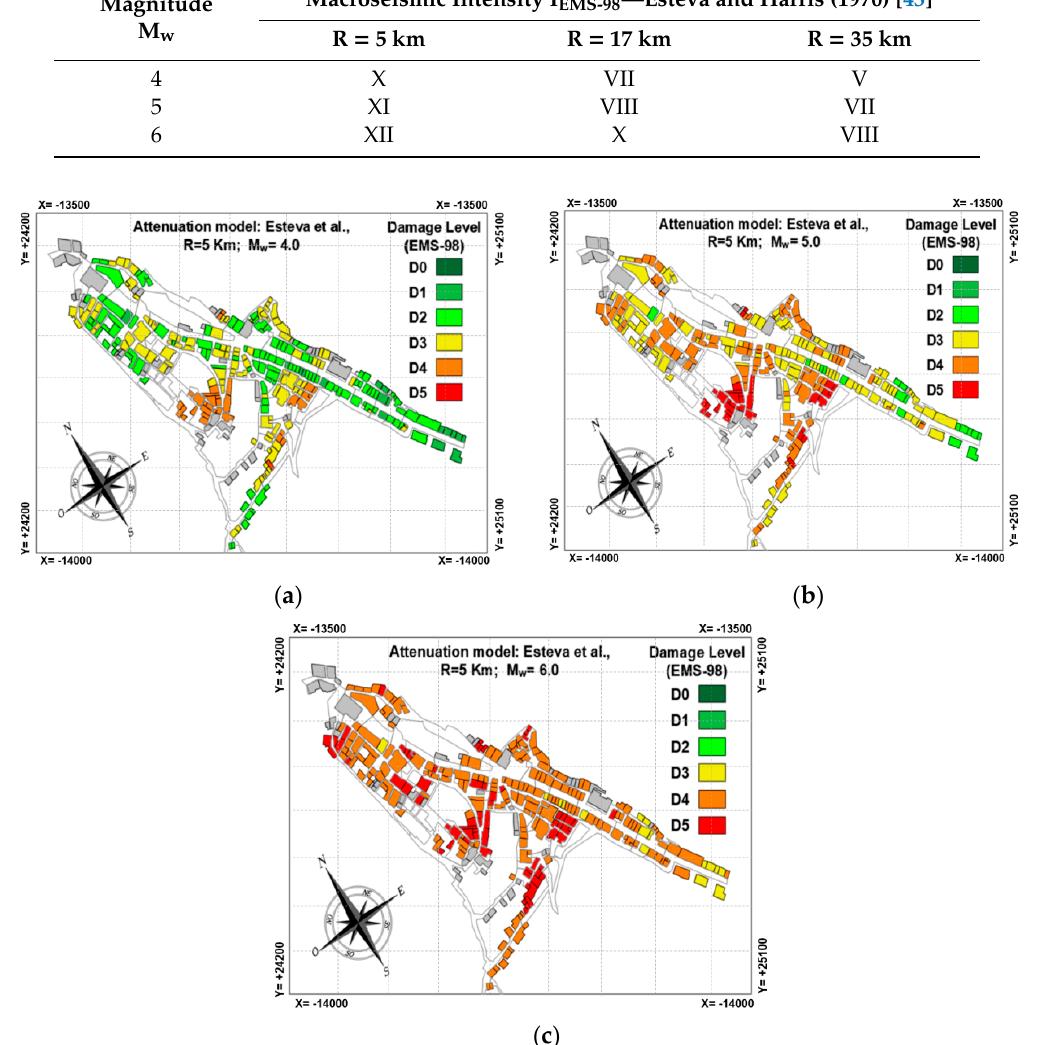
Figure 14. The impact damage scenarios in the investigated urban area (for R = 5 Km and M w variable from 4 to 6) according to Esteva and Harris’ attenuation law.